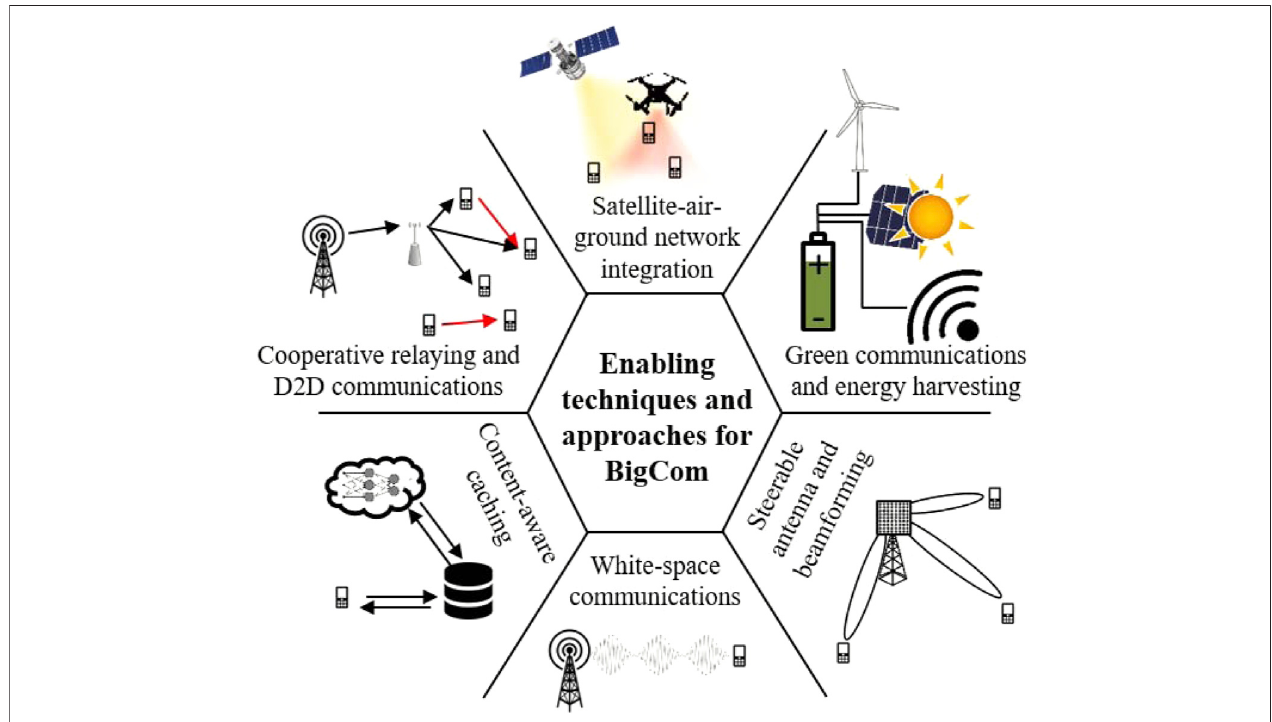
FIGURE 4 | Techniques and approaches enabling